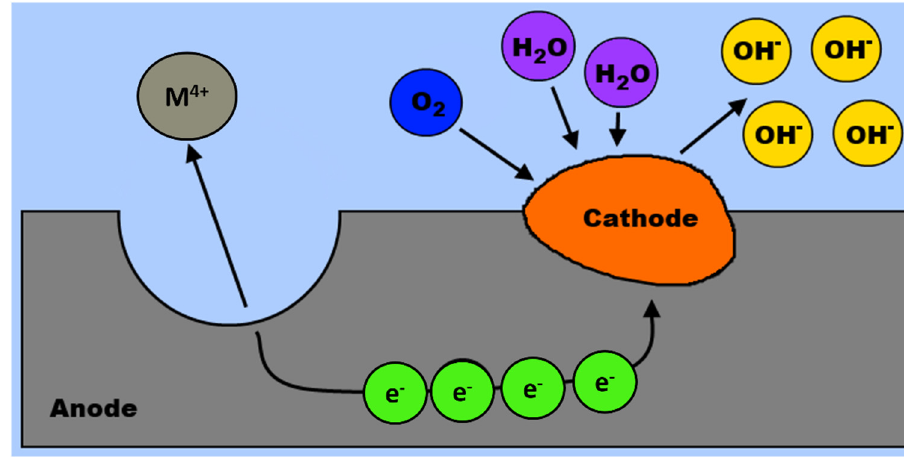
Figure 6. An elementary electrochemical corrosion cell on metal surface.